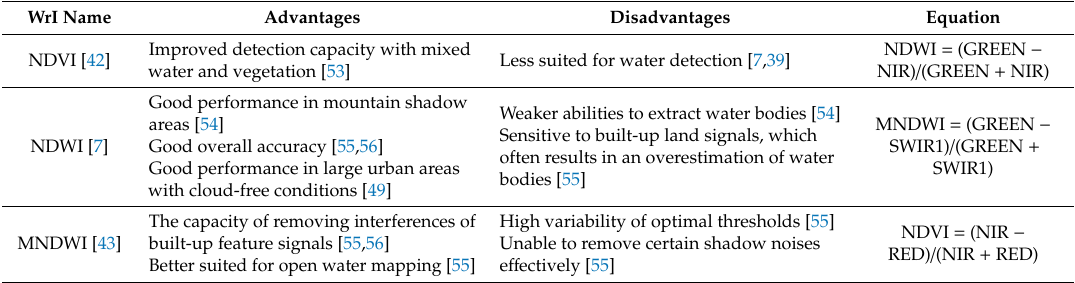
Table 2. Advantages and disadvantages of optical Water-related Indices